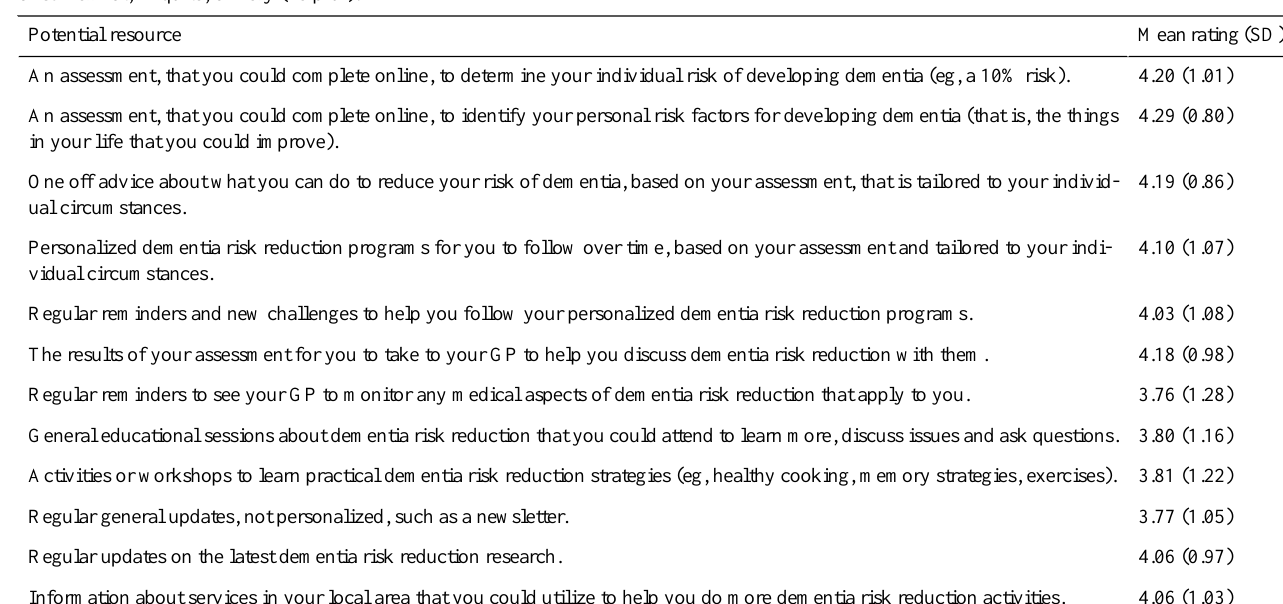
Table 7. Mean (SD) ratings of how useful respondents felt suggested additional resources would be to them (n=65). Ratings: 1=not at all; 2=not very; 3=somewhat; 4=quite; 5=very